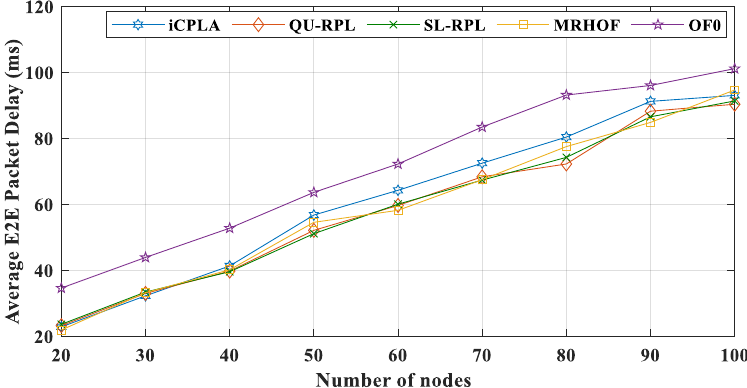
Figure 8. Comparison of average E2E packet delay between i CPLA, QU-RPL, SL-RPL, MRHOF, and OF0 with 𝛼 = 0.3 and 𝛽 = 0.7 in a network of 20 to 100 nodes.